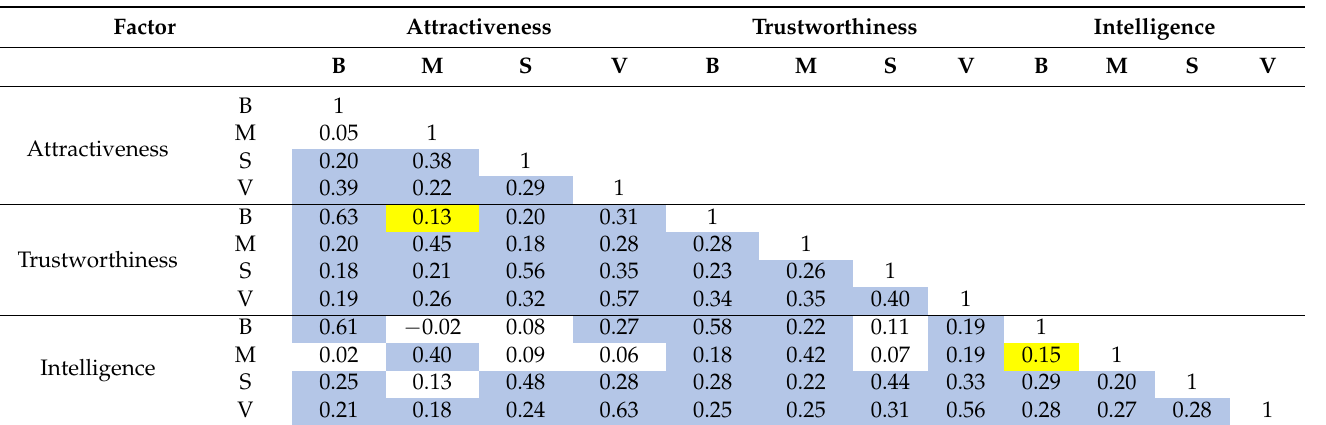
Table A1. Pearson correlations for Experiment